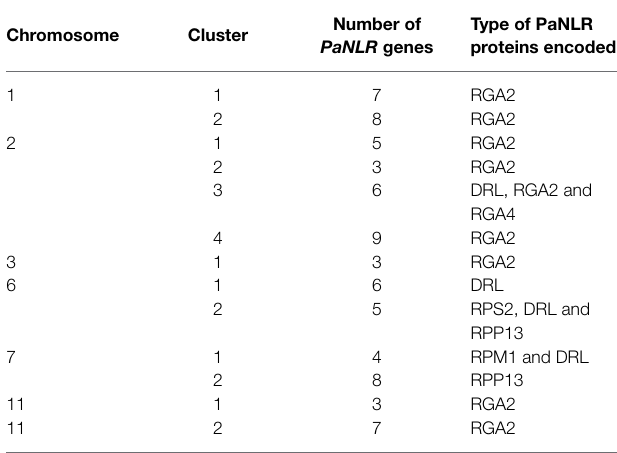
TABLE 1 | Types of resistance genes found within PaNLR gene clusters on different chromosomes within the genome of Persea americana (West-Indian pure